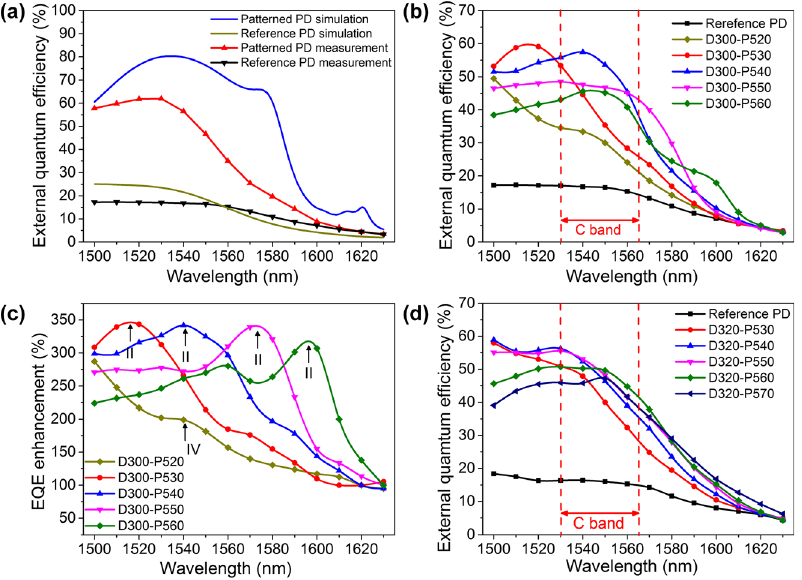
Figure 3: Enhanced external quantum efficiency of the patterned PD. (a) FDTD simulated and experimentally measured EQE spectra of the 30- μ m-diameter patterned PD. Diameter/period of the hole-array is 320/540 nm. Measured EQE is 57% at 1540 nm, while the simulated one is as high as 80% around 1540 nm. Both results show strongly enhancedabsorptioncomparedwiththereferencePD,respectively.(b – c)MeasuredEQEspectra(b)andthecorrespondingEQEenhancement spectra (c) for the 30- μ m-diameter patterned PDs as the hole-array (hole diameter: 300 nm) period increases from 520 to 560 nm, exhibiting peak enhancement of more than 300% from 1500 to 1600 nm. The wavelength of the EQE peak increases approximately linearly with the period. (d) Measured responsivity spectra for the 14- μ m-diameter patterned PDs as the hole-array (hole diameter: 320 nm) period increases from 530 to 570